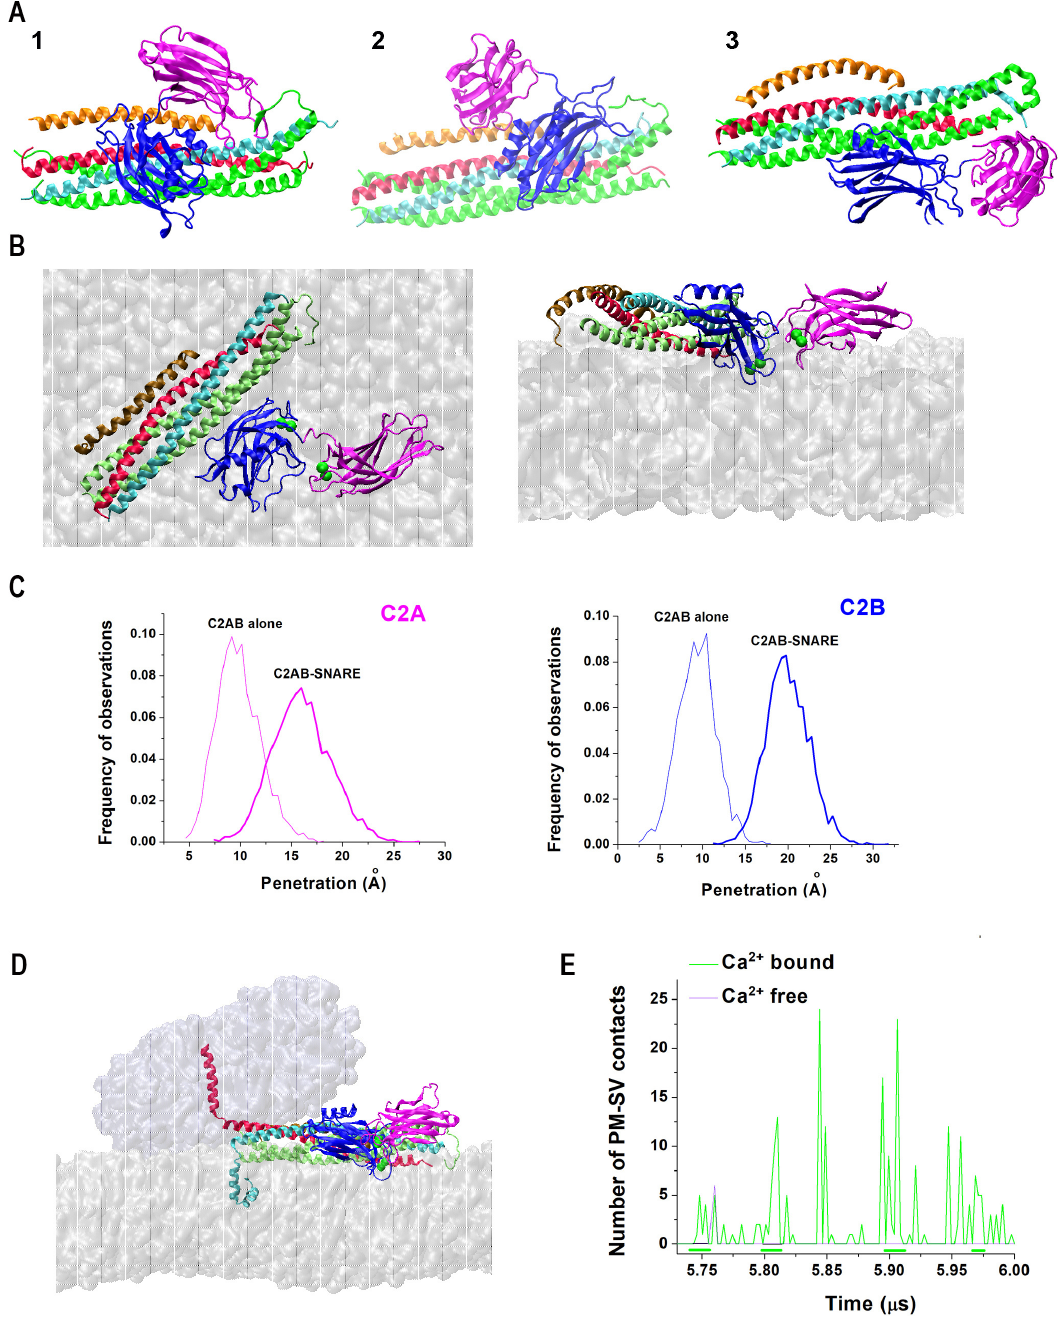
Figure 4. The prefusion Syt1-SNARE-Cpx complex. ( A ) Three conformational states of the Syt1- SNARE-Cpx complex obtained by AAMD simulations. Note that States 1 and 2 have Syt1 directly interacting with Cpx. ( B ) Two views of the prefusion Ca 2+ Syt1-SNARE-Cpx complex attached to the PM. Note the Ca 2+ -bound tips of C2 domains immersed into the PM. ( C ) The attachment of the C2B domain to the SNARE bundle decouples C2 domains and enables their deeper penetration into the PM. The graphs show the distributions of the penetration depths over respective 5 µ s trajectories. ( D ) The prefusion Ca 2+ Syt1-SNARE-Cpx complex drives the merging of the SV (top) and the PM (bottom) bilayers. ( E ) The number of SV-PM Van der Waals contacts for the Ca 2+ -bound and Ca 2+ -free prefusion Syt1-SNARE-Cpx complexes along respective trajectories. Note continuous stretches of the SV-PM attachment for the Ca 2+ -bound complex (green lines). In contrast, for the Ca 2+ -free complex, the PM and SV bilayers are not in contact for most of the trajectory. Reproduced from